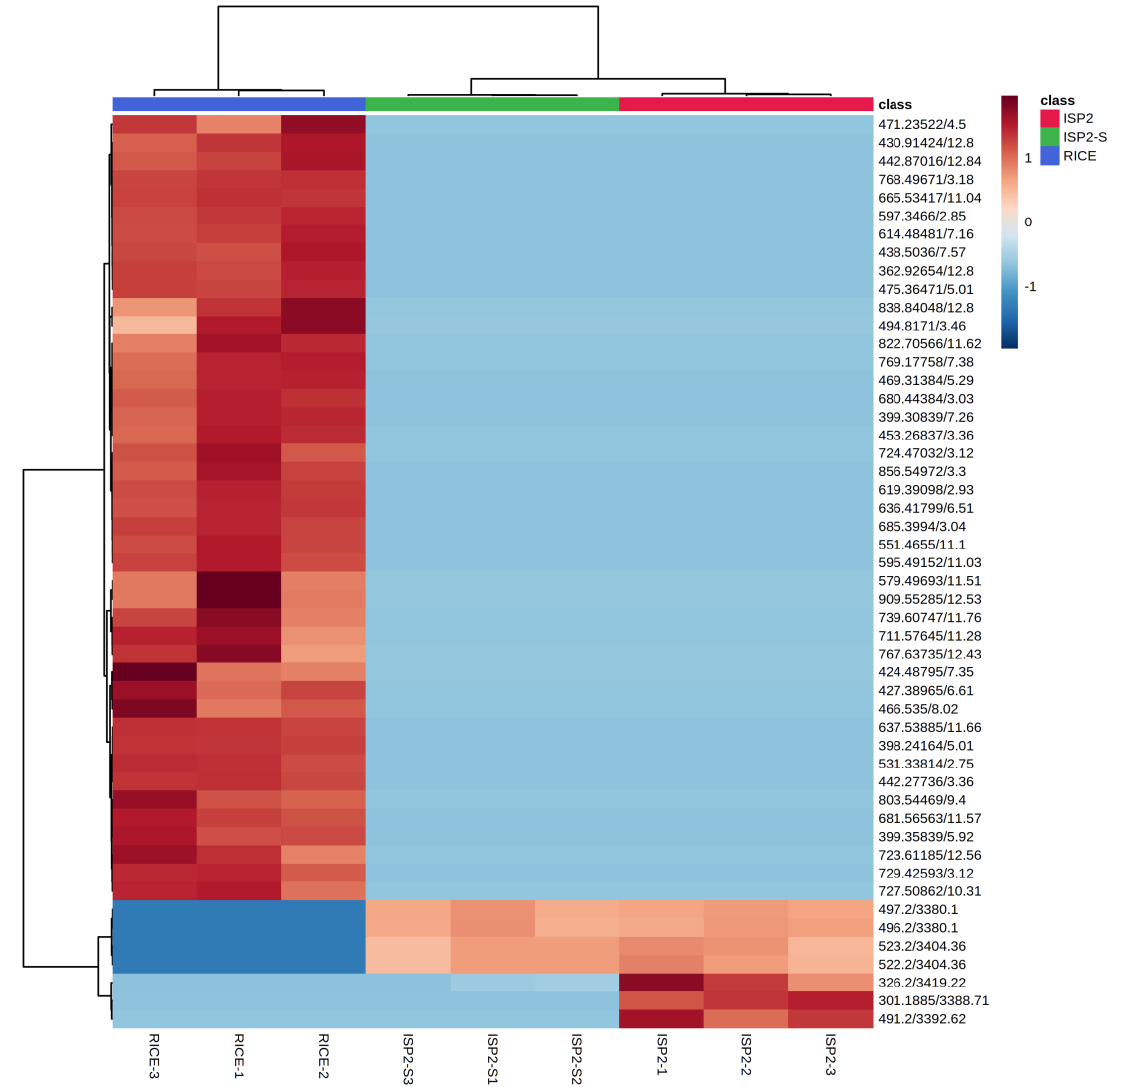
Figure 3. Hierarchical clustering of detected ions in ISP2 extract (red), ISP2-S extract (green), and RICE extract (blue). Heatmap displays relative abundance (low, blue; high, red) of respective features.